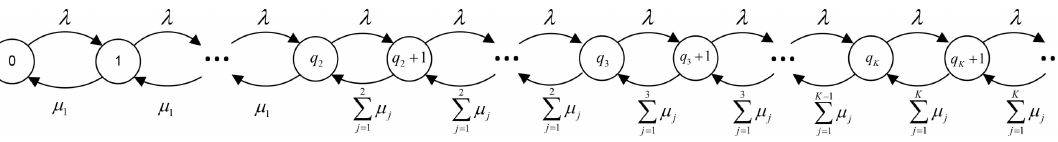
Figure 4. The state transition diagram for the queueing system S l